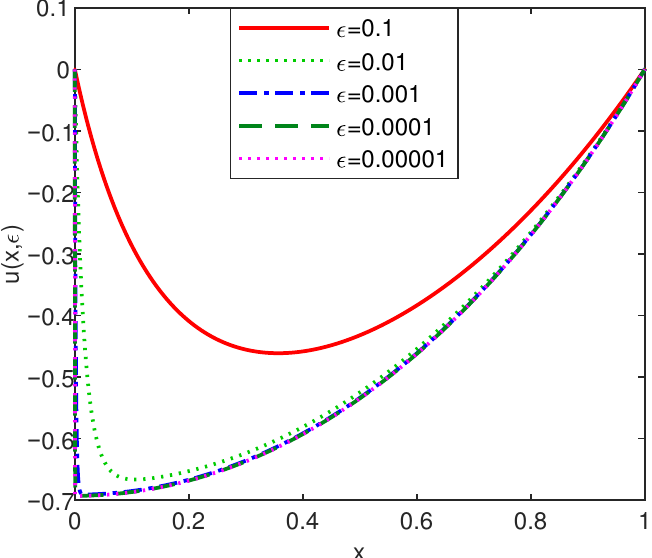
Figure 10. Five solutions to problem (17) for various values of the parameter (cid:101)